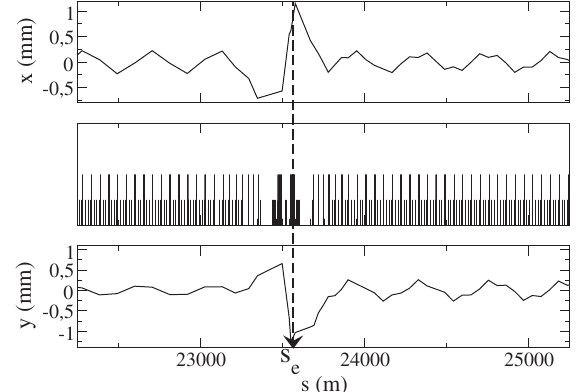
FIG. 2. Max trajectory whose horizontal and vertical components at s e are positive and negative respectively. The other three possible combinations produce a total of four kinds of max